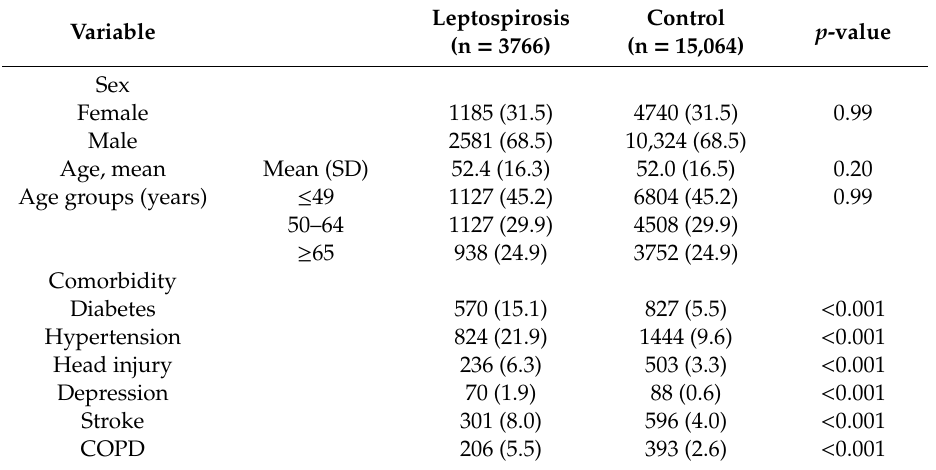
Table 1. Demographic characteristics and comorbidities in patients with and without leptospirosis.